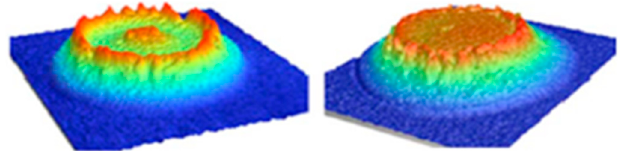
Figure 4. Coffee ring effect. Reprinted with permission from [6].